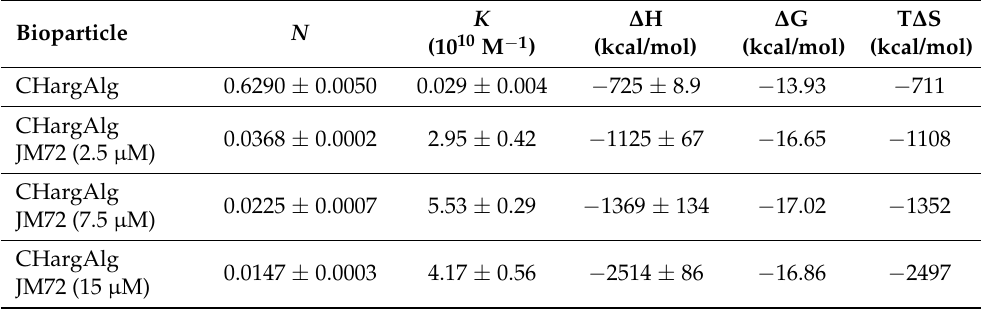
Table 1. Thermodynamic parameters obtained for the interaction between alginate and CHarg without polypeptide and in the presence of different concentrations of